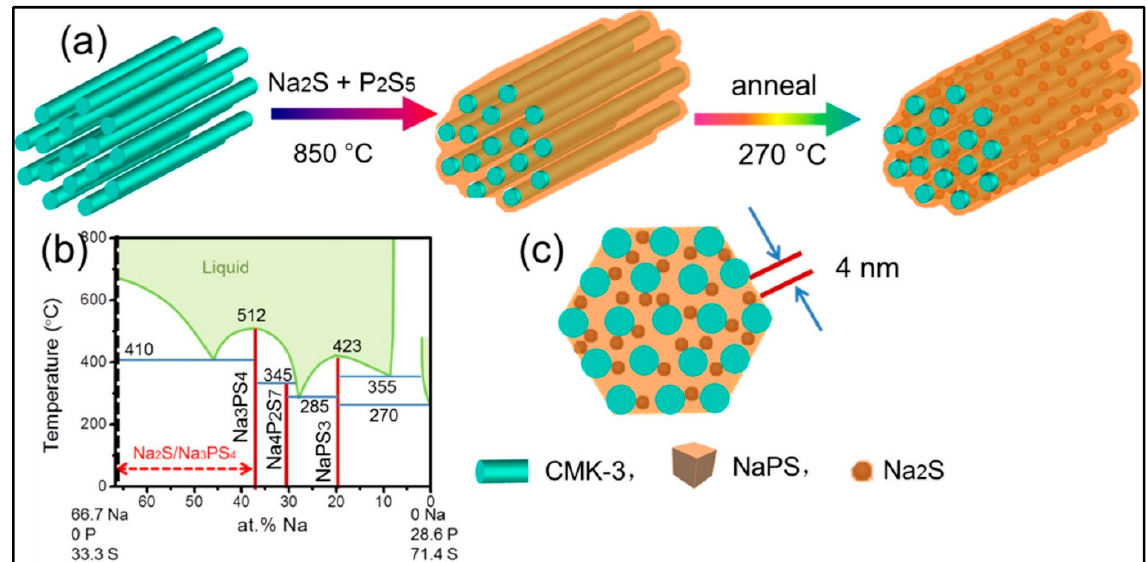
Figure 10. ( a ) Schematic representation of the synthesis procedure of Na 2 S-Na 3 PS 4 -CMK-3 nanocomposites cathode; ( b ) Na 2 S and P 2 S 5 phase diagram; ( c ) Na 2 S-Na 3 PS 4 -CMK-3 nanocomposites. (Reprinted with permission from [143]; Copyright 2018, ACS Nano 2018 , 12 , 3360–3368.)